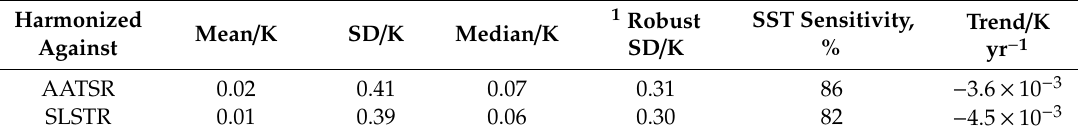
Table 1. Statistics of di ff erence between MTA SSTs derived by optimal estimation and matched drifting buoy SSTs (after skin